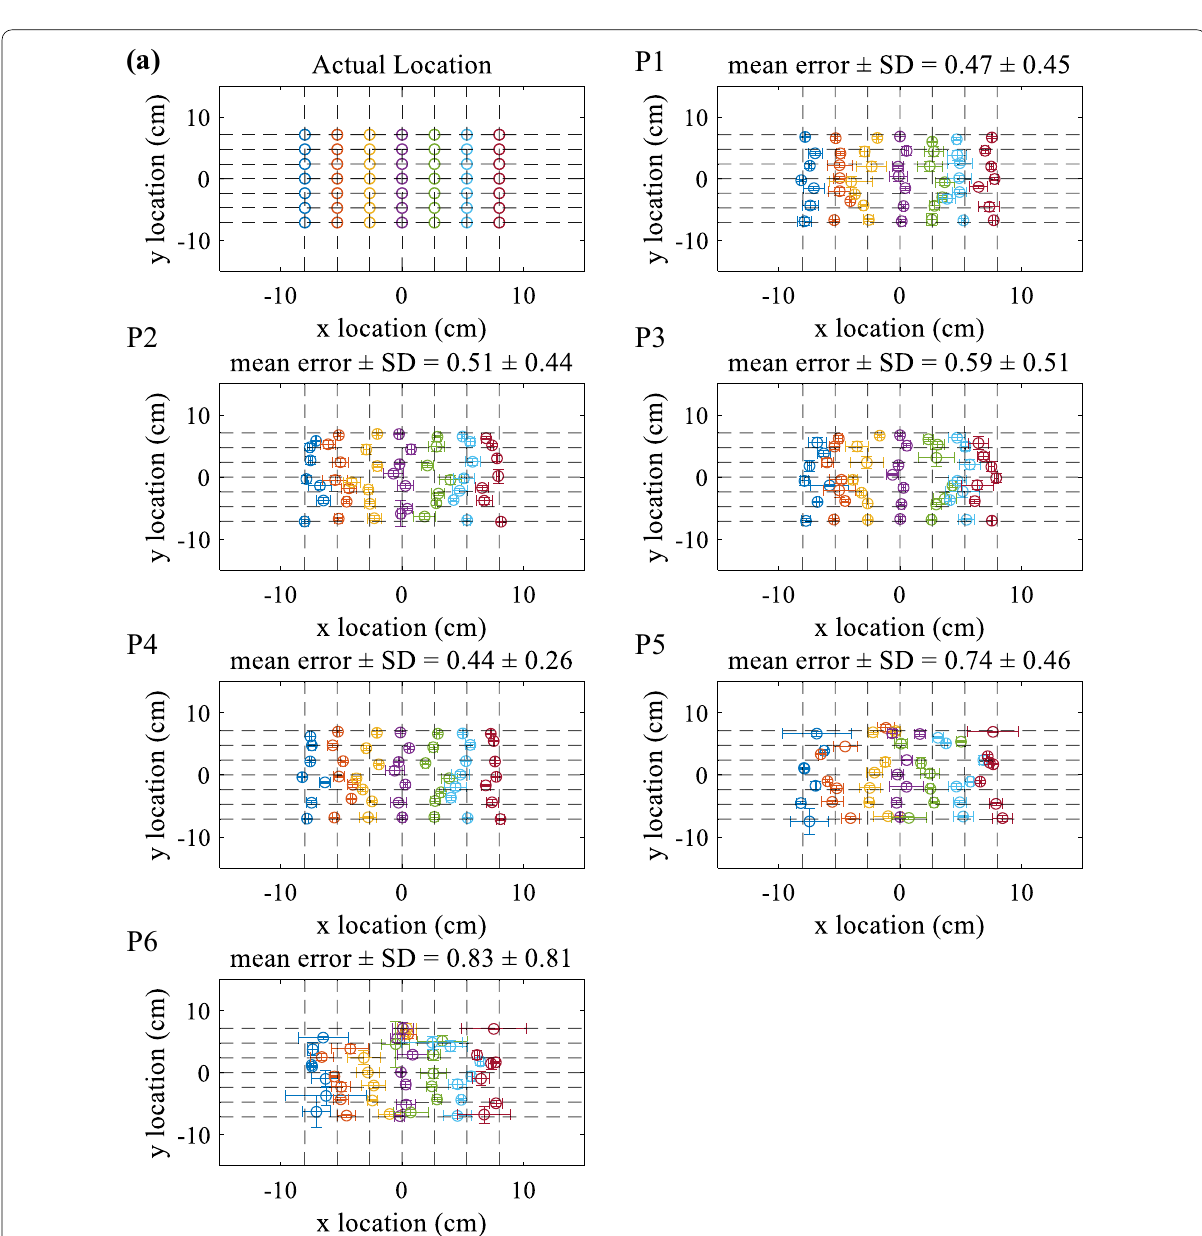
Fig. 4 Results of the personalized model constructed using samples from an individual target participant: a Actual locations of the 49 points. (P1– P6) Mean estimated location and standard deviation of each of the six participants,